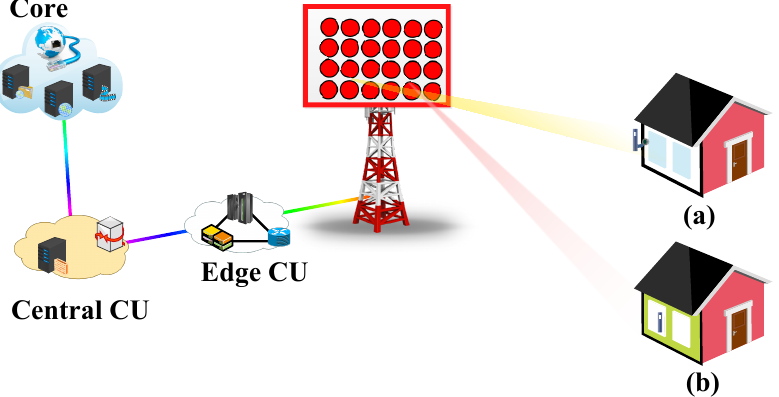
Figure 16. Implementation of ( a ) outer router for low-e glass and ( b ) home router for normal